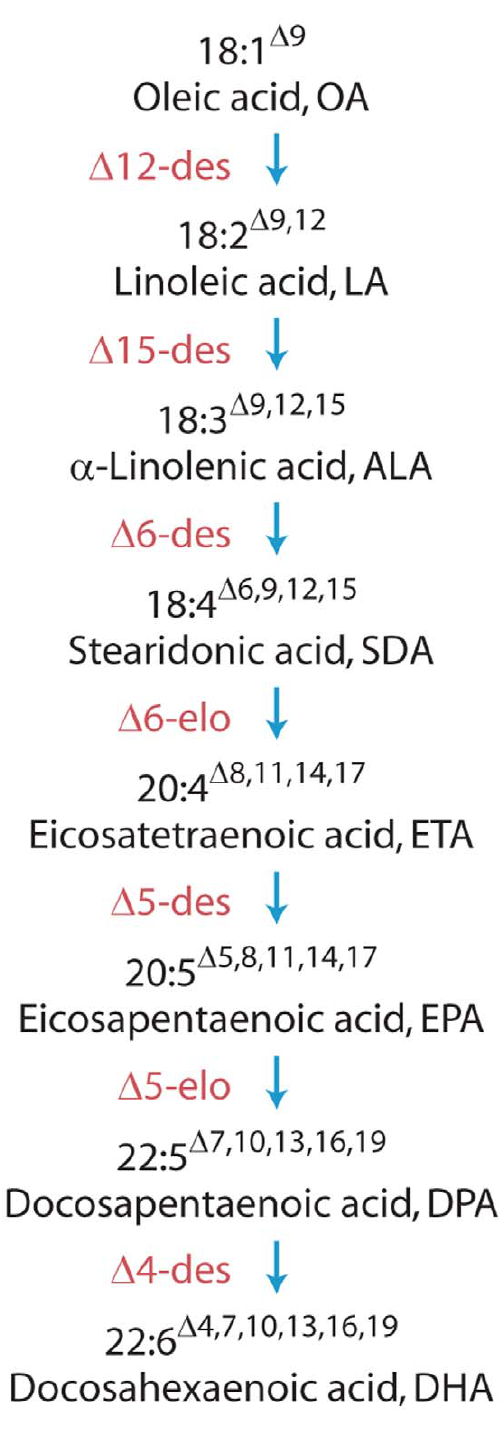
Figure 1. DHA biosynthesis pathway described in this study where ‘des’ refers to desaturase and ‘elo’ to elongase.